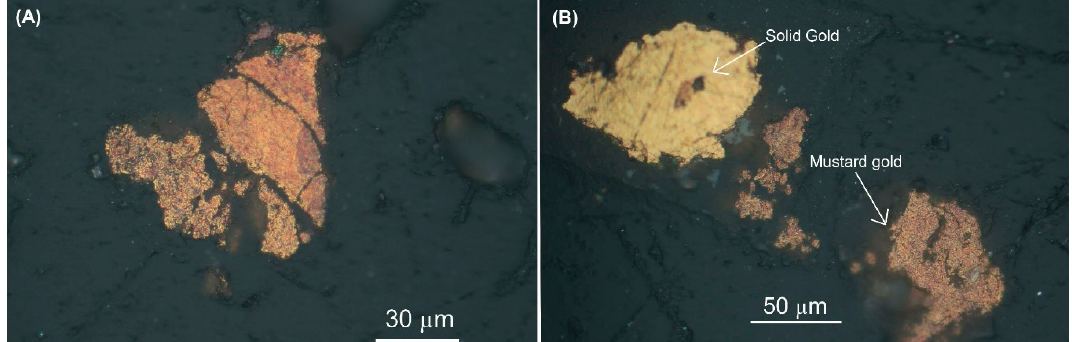
Figure 4. Native gold from the Gaching ore occurrence (Maletoyvayam ore field), Kamchatka, Russia (polished sections in reflected light) (imaged by N. Tolstykh). ( A ) Color of mustard gold is brown yellow to brown under reflected light. ( B ) Porous gold (mustard gold) is observed along with a homogeneous gold grain (solid gold).